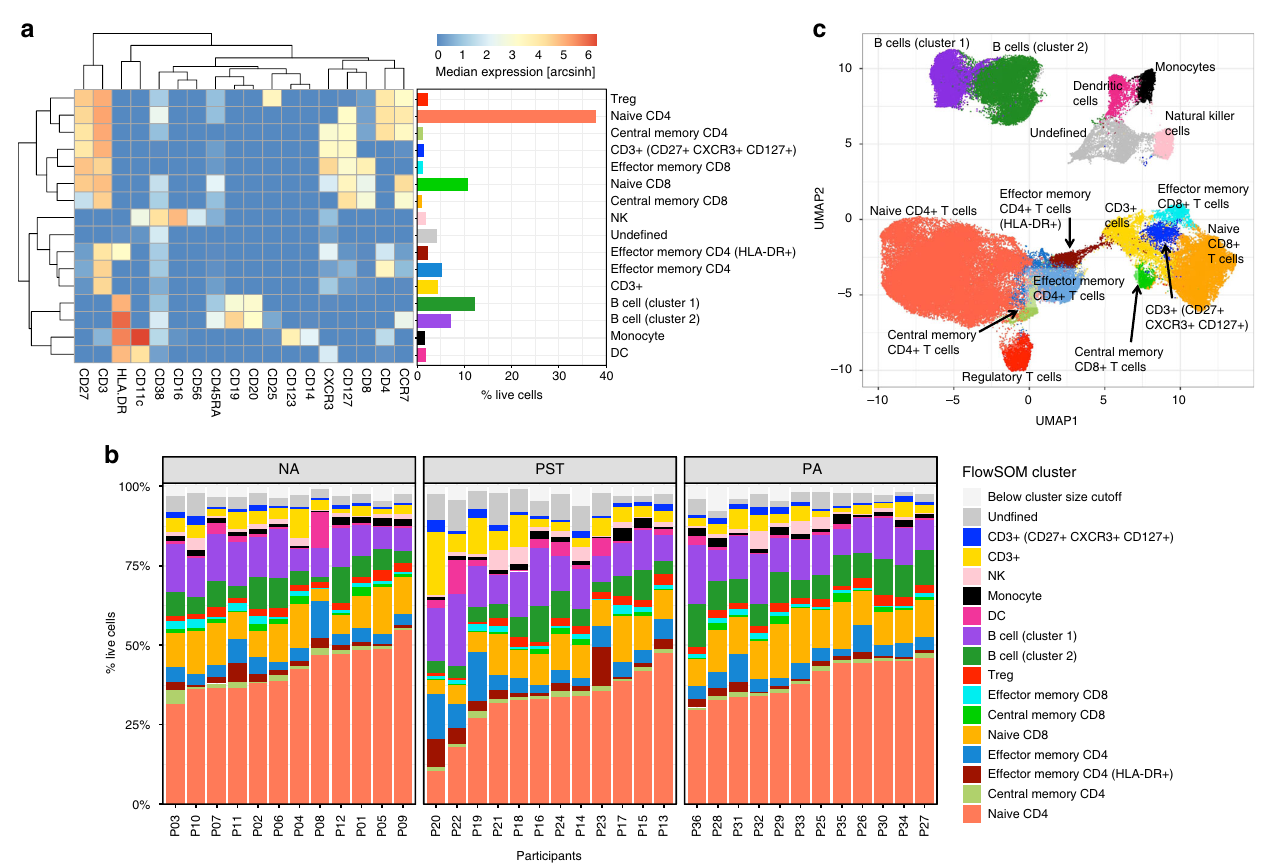
Fig. 3 Unsupervised analysis using FlowSOM reveals distinct immune cell clusters in PBMC from 1-year-old infants. a Clustering analysis with FlowSOM revealed 16 cell clusters, shown here as a heatmap of the median expression of 18 lineage markers along with a bar graph representing each cluster as percentage of live cells and the cell phenotype that each cluster was assigned based on lineage marker expression pattern. b Stacked bar graph representing all clusters identi fi ed in each individual, strati fi ed by clinical outcome for non-allergic (NA) ( n = 12), peanut-sensitized tolerant (PST) ( n = 12), and peanut-allergic (PA) ( n = 12) infants. Clusters with <1% of the analyzed cells were excluded from all other analyses and are represented here as “ below cluster size cutoff ” . c Uniform Manifold Approximation and Projection (UMAP) representation of 100,008 randomly selected cells (2778 per fi le) with clusters from the FlowSOM analysis overlaid. The same color is used for each cluster/cell type across all plots. Source data are provided as a Source Data fi